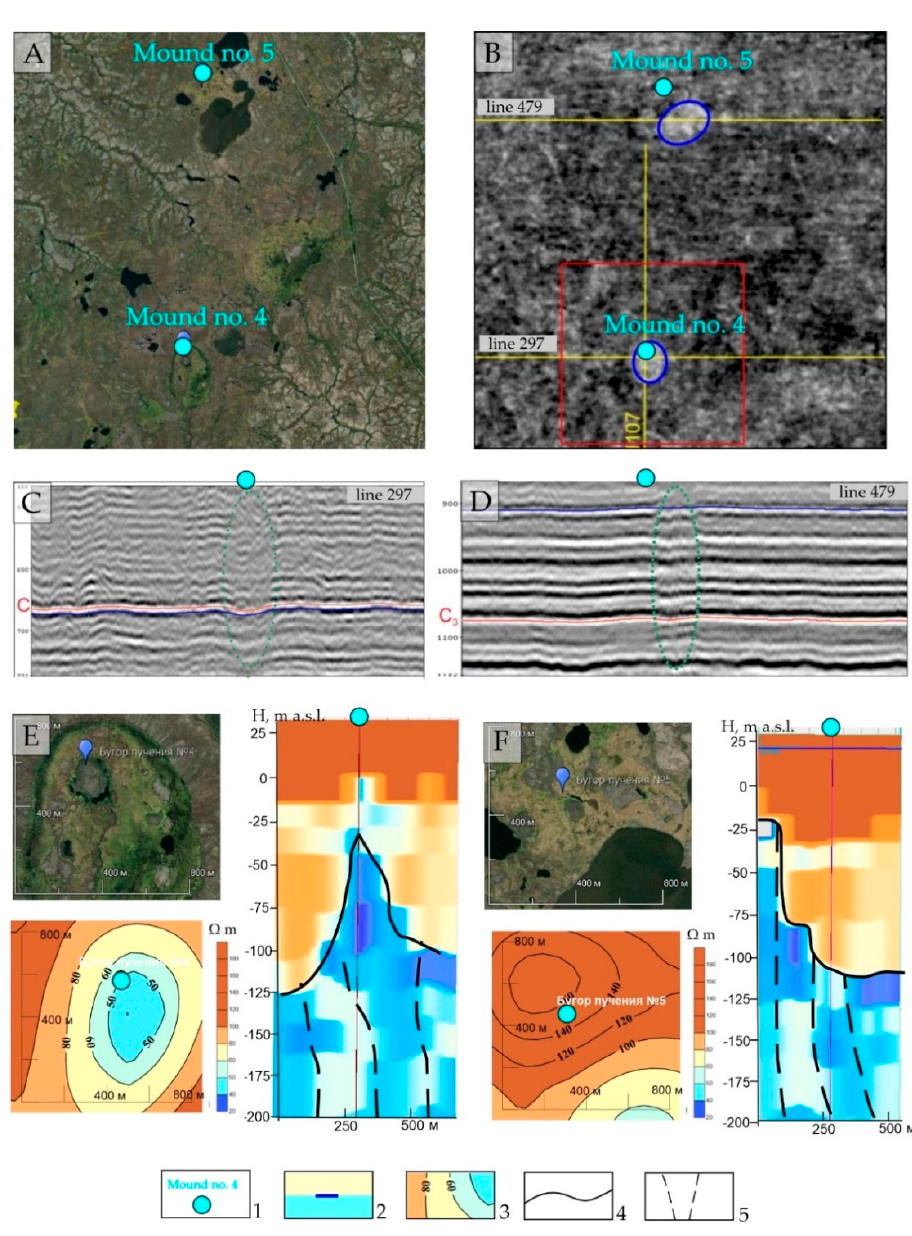
Figure 6. Mounds produced by frost heaving in sTEM and seismic data. ( A ) Satellite image; ( B ) Cretaceous sediments, 3D seismic image (a fragment); ( C , D ) seismic sections across mounds 4 ( C ) and 5 ( D ); ( E , F ) location and resistivity cross-sections of mounds 4 ( E ) and 5 ( F ). 1 = location marks of mounds; 2 = resistivity layers; 3 = resistivity contour lines, Ω ·m; 4 = permafrost base inferred from sTEM data; 5 = gas migration conduits inferred from sTEM data.